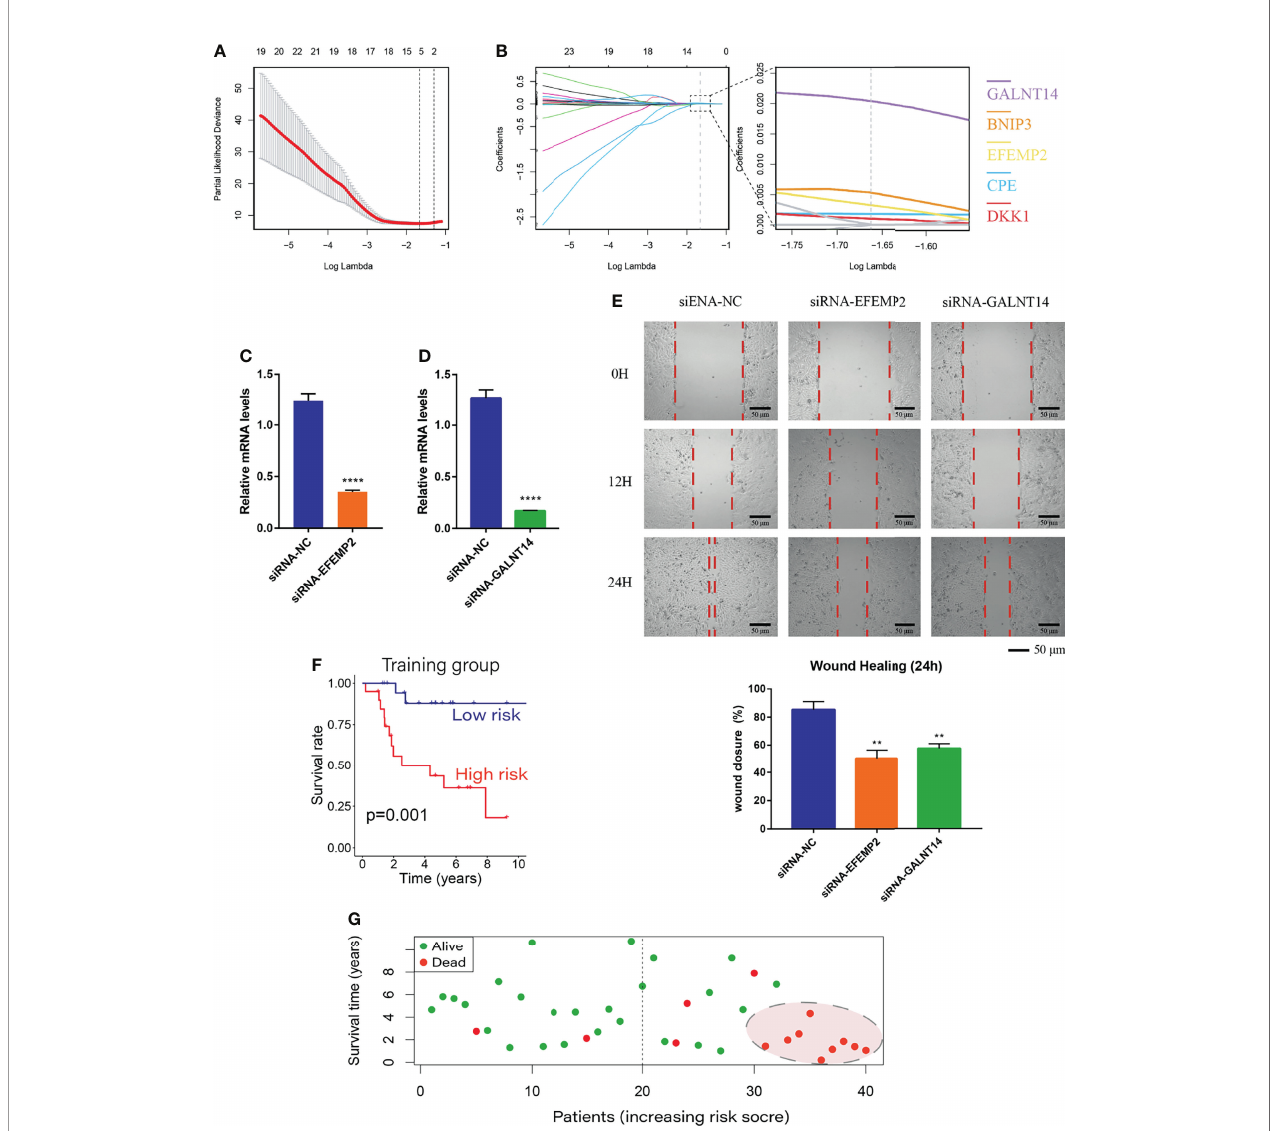
FIGURE 4 | Establishment of the BCDEG model. (A) The error rate for model cross-validation. Each lambda value with error bars gives a con fi dence interval for the cross-validation error rate. The vertical dashed line on the left represents the minimum error, and the number of genes in each model is given at the top of the plot. (B) A model considering prognosis-related genes was produced by maximizing the appropriate penalized log-likelihood. Lasso penalty leads to convergence of gene coef fi cients, and the colored line shows the trend of gene coef fi cients as a function of lambda. The number of genes with nonzero regression coef fi cients is shown at the top of the plot. (C) siRNA-EFEMP2 signi fi cantly inhibited the expression of EFEMP2. (D) siRNA-GALNT14 signi fi cantly inhibited the expression of GALNT14. (E) Degree of wound healing at 0, 12 and 24 hours; the red dotted lines represent the edge of the scratch. (F) Survival curve for the training group. The prognosis of the low-risk group was better than that of the high-risk group. (G) Survival status plot of the training group ranked according to risk score. **p < 0.01 and ****p <